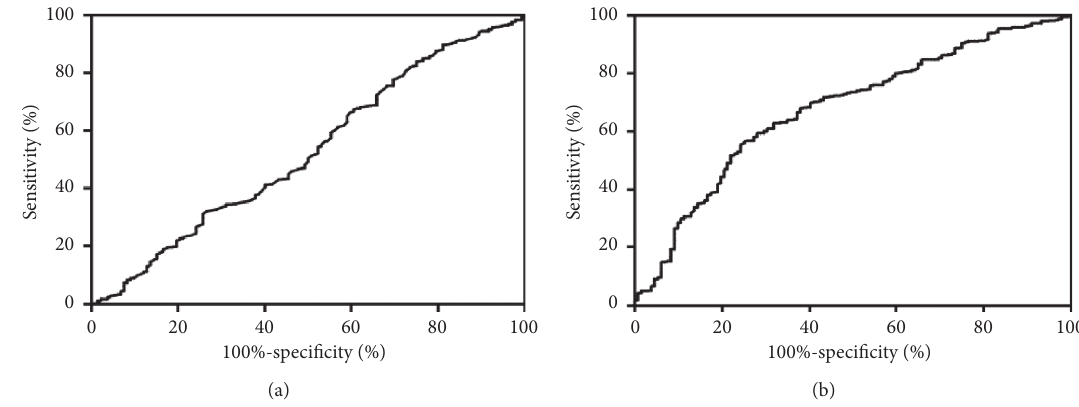
Figure 5: The ROC analysis of PLC and NLR. (a) ROC curves of PLC for mortality ( p � 0 . 361). (b) ROC curves of NLR for mortality (area under the curve � 0.677; 95% confidence interval: 0.626–0.728, p < 0 . 001). Abbreviations: ROC, receiver operating characteristic curve; PLC, platelet count; NLR, neutrophil-to-lymphocyte ratio. Table 3: Predictors of in-hospital mortality in univariable and multivariable Cox regression